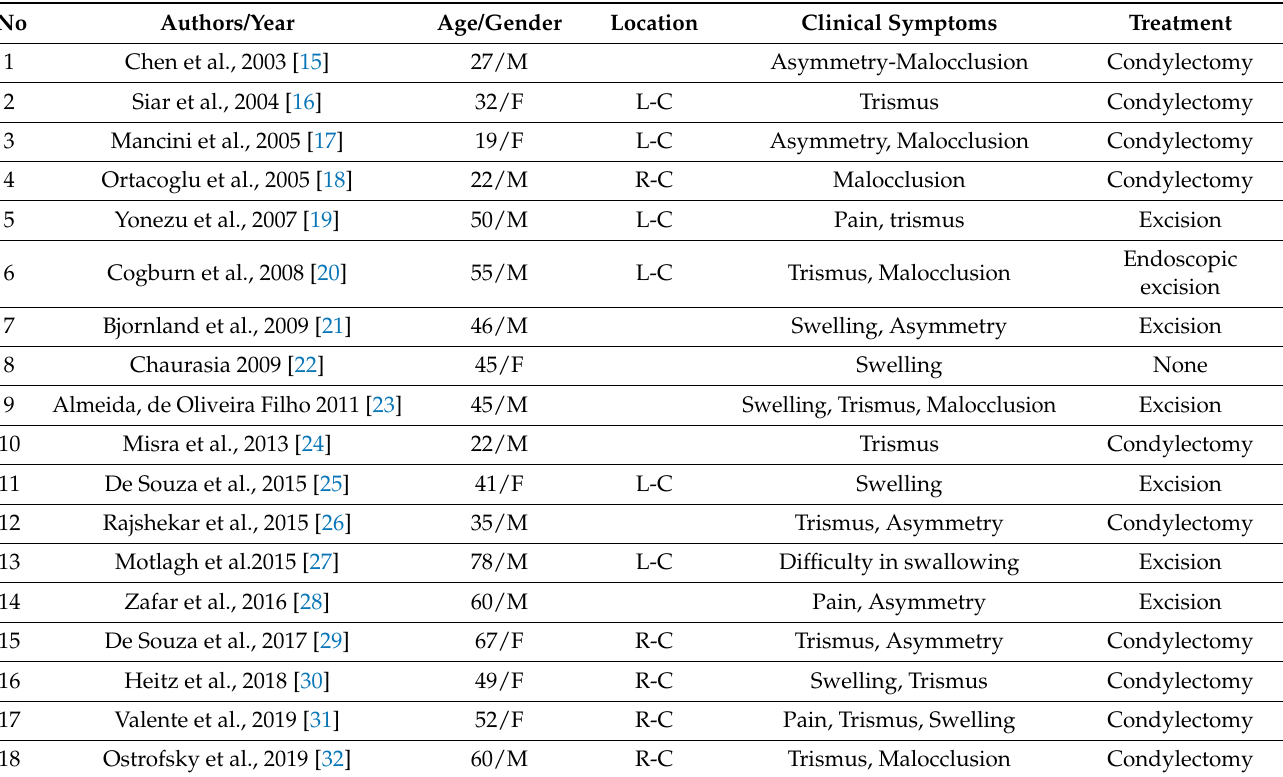
Table 1. Reported cases of mandibular condyle osteomas with a description of their